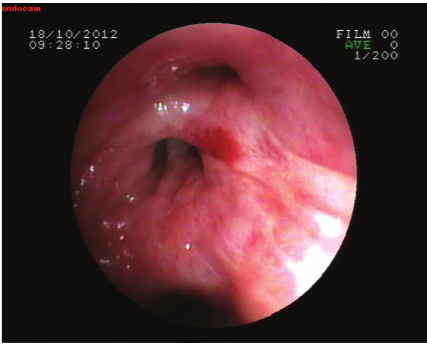
Figure 2: Stenosis with mucosal tumor infiltration in right upper lobe bronchus.